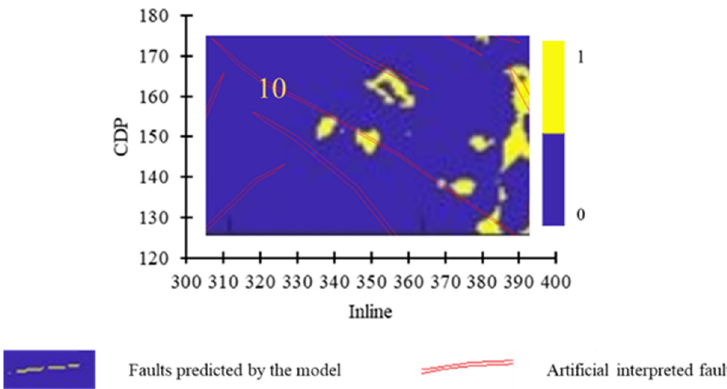
Figure 20. The prediction result of Fault 10 by Region C as training set.